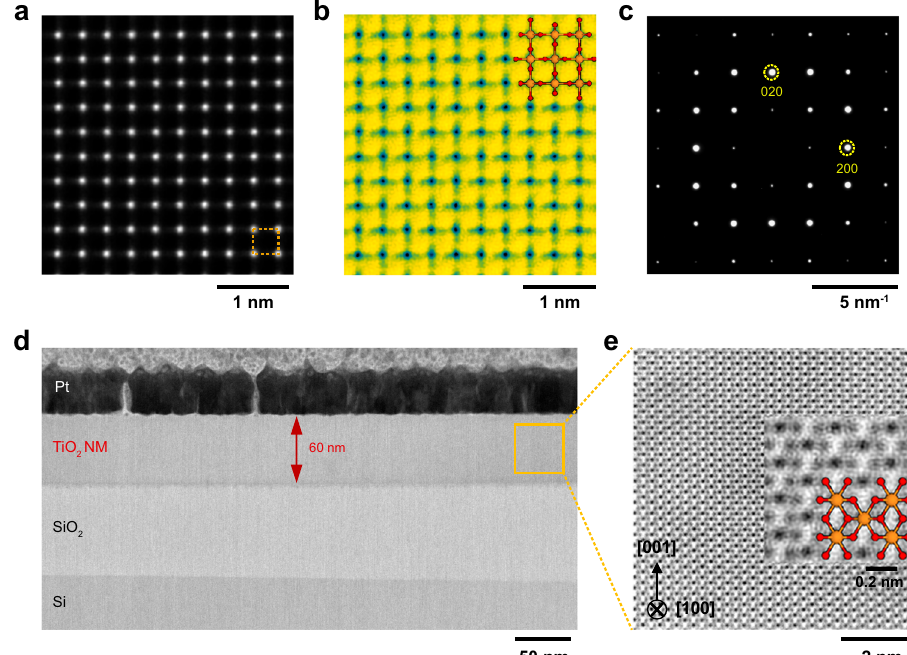
Fig. 3 STEM analysis of freestanding single-crystal TiO 2 nanomembrane (NM). a HAADF-STEM, b ABF-STEM, and c SADP images from the plane-view observation on 20-nm-thick freestanding TiO 2 NM. The white spots in HAADF-STEM, which are identical to Ti atoms, are consistent with cation sites of [001] R -projected rutile structure. The atomic arrangement of ABF-STEM, visualization of oxygen atoms, was also identical to anion sites of rutile structure; the results indicate that atomic arrangement of freestanding TiO 2 NM was identical to the single-crystal rutile structure without defective features. d , e are the cross-sectional ABF-STEM images of TiO 2 NM, the quality of which is crystallographically high with perfect registry of Ti (orange color in e ) and O (red color in e ) atoms in rutile